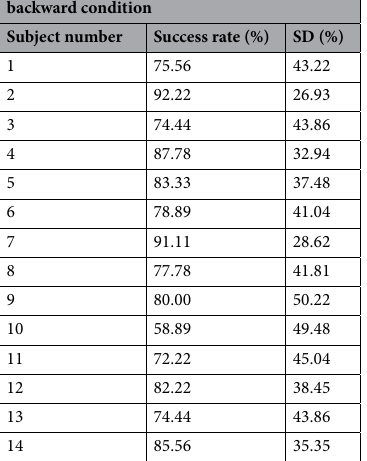
Table 2. Individual success rates (and standard deviations (SD)) in blindfolded sighted participants for the backward object localization